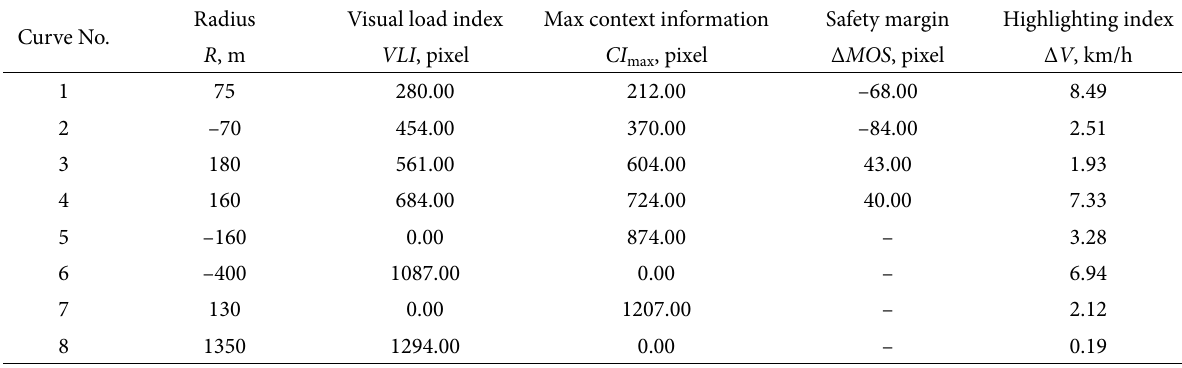
Table 2. Relationship among geometrical and workload variables Curve